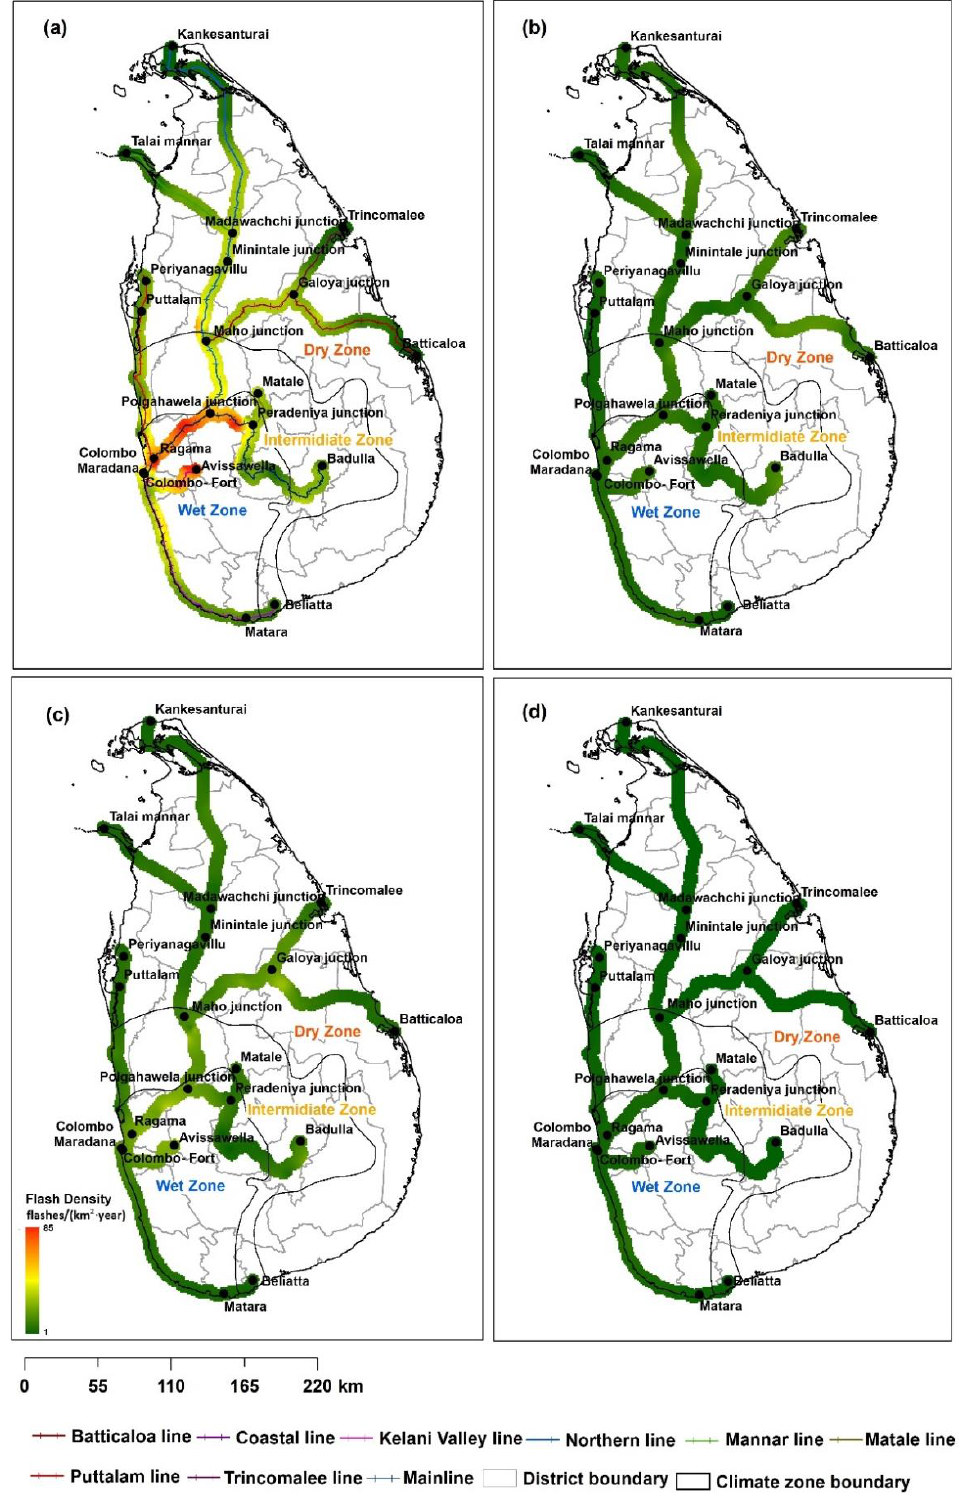
Figure 6. Spatial variability of the lightning flash density over the railway network of Sri Lanka in the four climate seasons from 1998 to 2014 ( a ) FIM, ( b ) SWM, ( c ) SIM, ( d ) NEM.